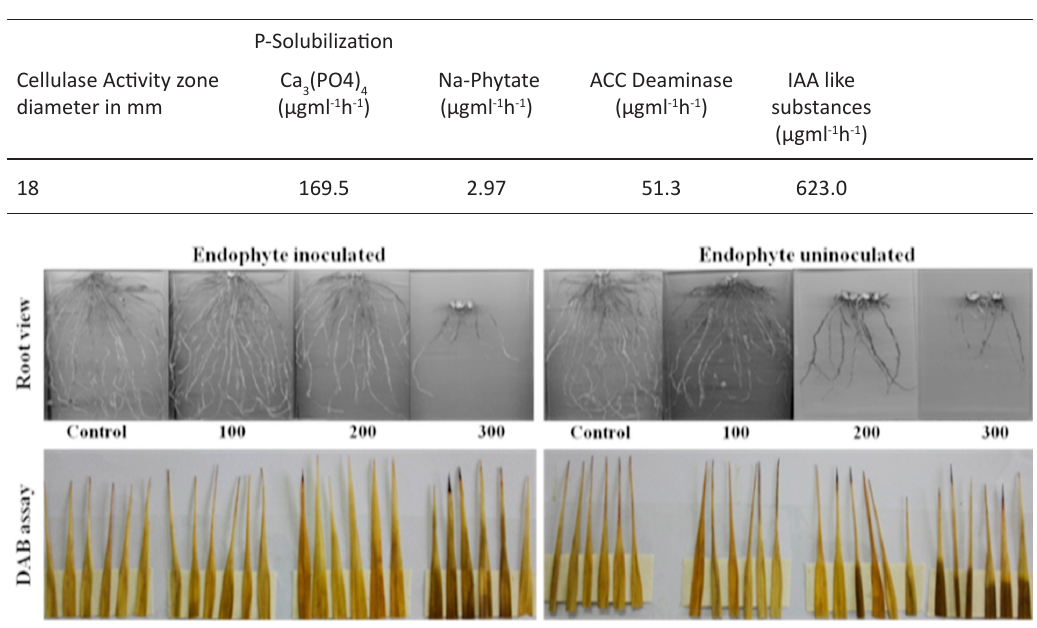
O activity in fully 2 2